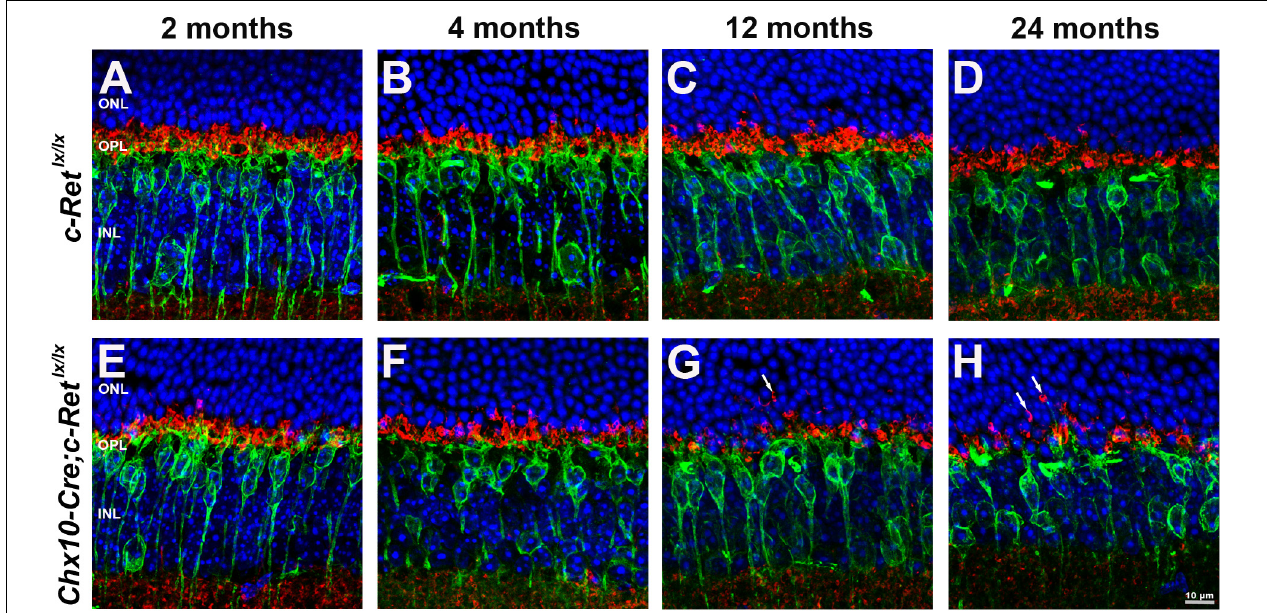
FIGURE 6 | Immunohistochemistry of pre- and postsynaptic structures in C-Ret lx / lx and Chx10-Cre;C-Ret lx / lx retinas. Retinal sections of animals aged 2, 4, 12, and 24 months were immunostained with an anti-PKC- α antibody (green) and an anti-synaptophysin antibody (red), to label rod bipolar cells and the synapses of photoreceptors, respectively, followed by counterstaining with Hoechst dye, to indicate cell nuclei (blue) (A–H) . The processes of rod bipolar cells formed synapses with photoreceptors in the OPL of C-Ret lx / lx mice at all ages (A–D) and Chx10-Cre;C-Ret lx / lx mice at the ages of 2 and 4 months (E–F) . Ectopic synapses in the ONL were observed in 12- and 24-month-old Chx10-Cre;C-Ret lx / lx mice ( G,H , arrows). ONL, outer nuclear layer; OPL, outer plexiform layer; INL, inner nuclear layer. Scale bar, 10 µ